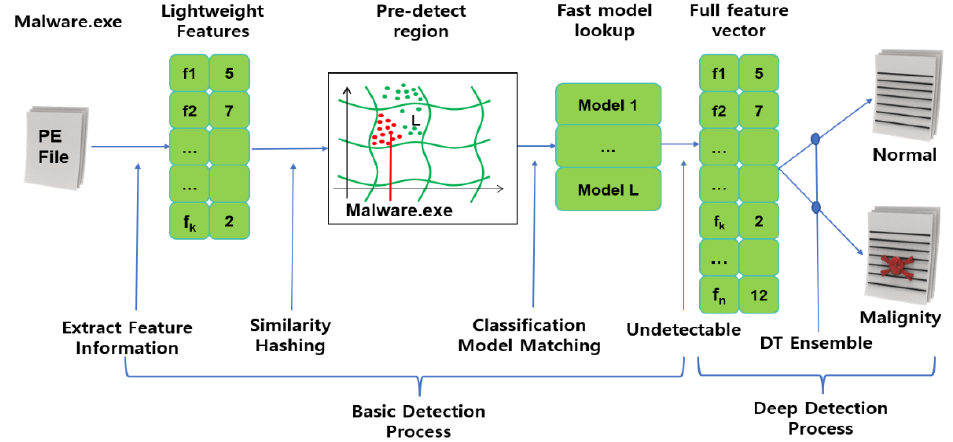
Figure 5. Pre-execution basic detection and deep detection processing process.